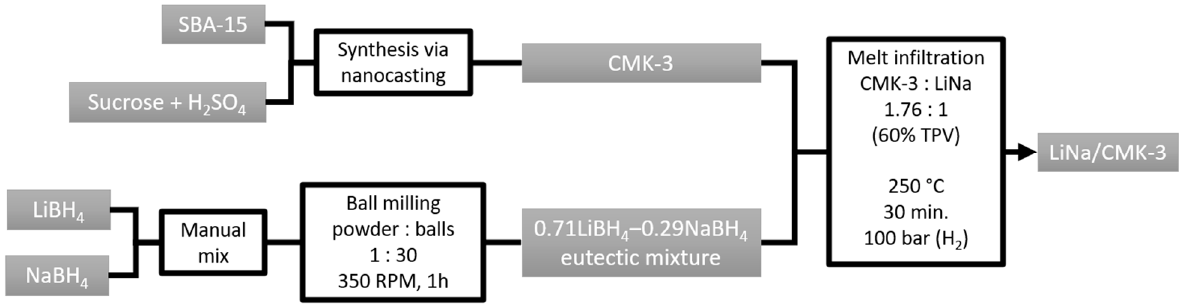
Figure 7. Schematic representation of the experimental procedure leading to the synthesis of the LiNa/CMK-3 composite.